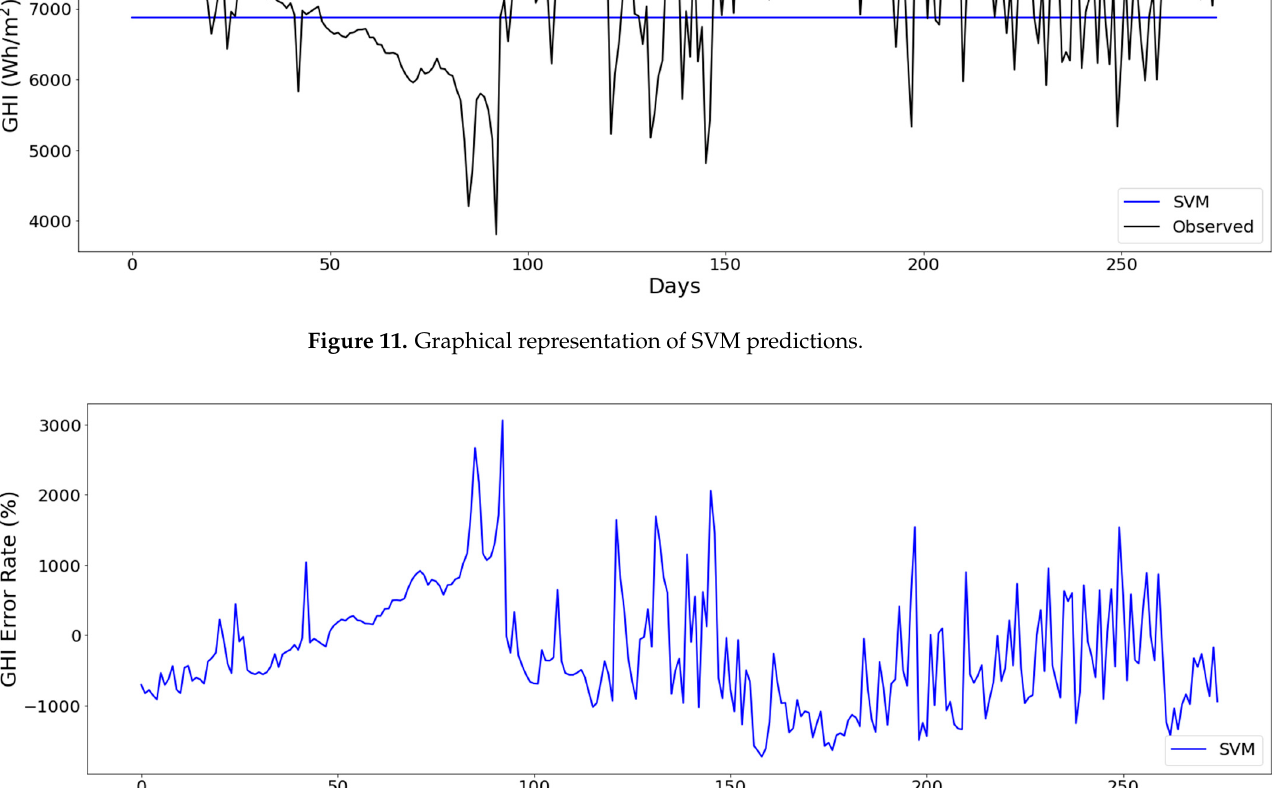
Figure 12. SVM error frequency rate.